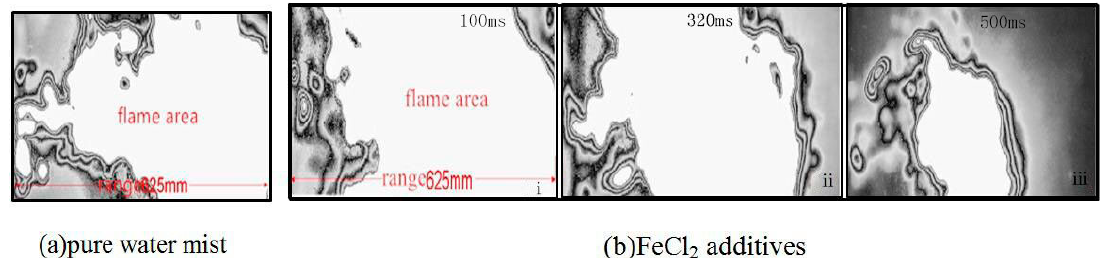
Figure 7. Comparison of the effect of the water mist, ( a ) with and ( b ) without the FeCl 2 additive, on gas combustion. Energies 2017 , 10 , 1566